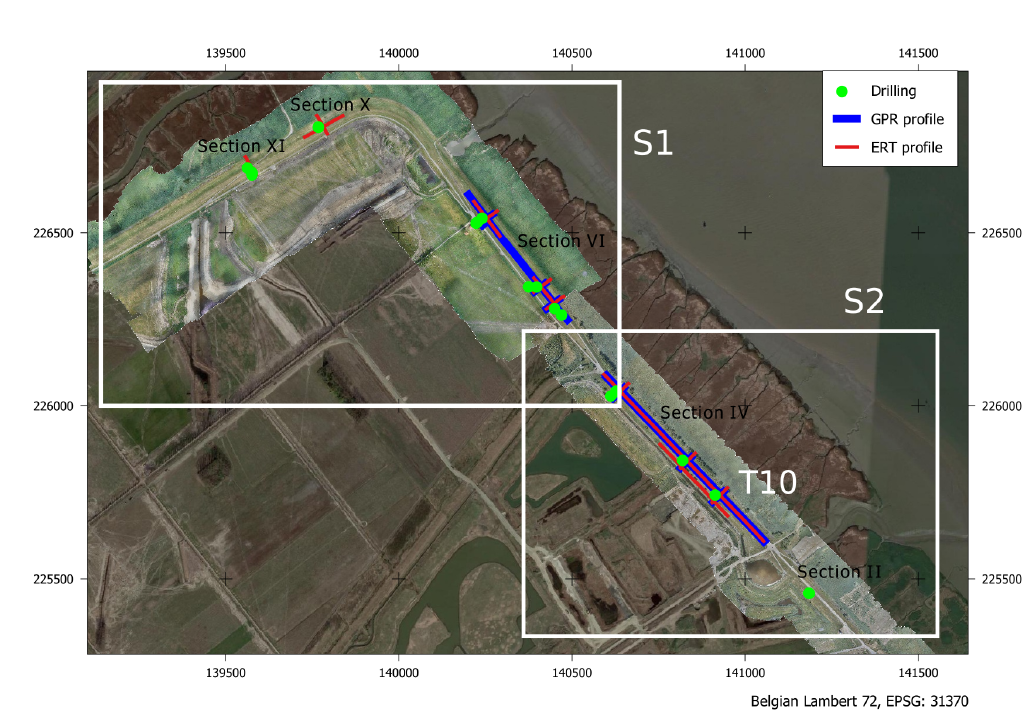
Figure 2. ERT and GPR profiles overlaid with the UAV-based high resolution orthophoto and Google data. White squares indicate the location of both S1 and S2 UAV surveys.